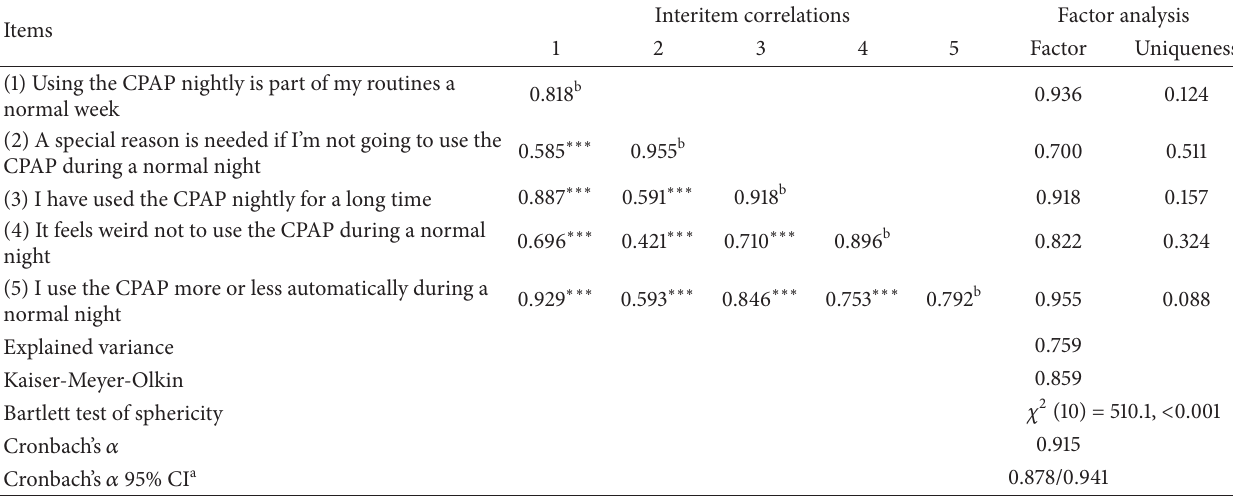
Interitem correlations Factor